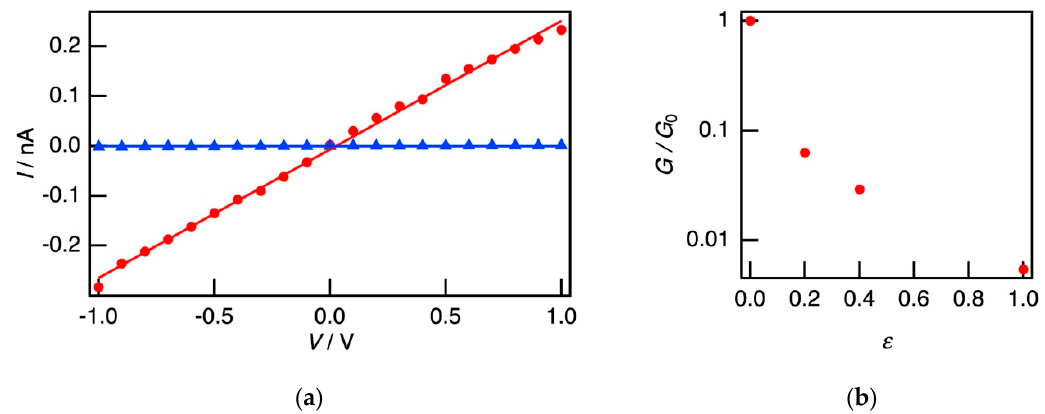
Figure 6. ( a ) I - V characteristics of the self-standing SBS film loaded with the P3HT nanofiber in the unstretched (red circles) and stretched (blue triangles) parts after the elongation treatment. ( b ) The ratio of the conductance of the stretched part G to the conductance of the unstretched part G 0 with changing the strain ε .